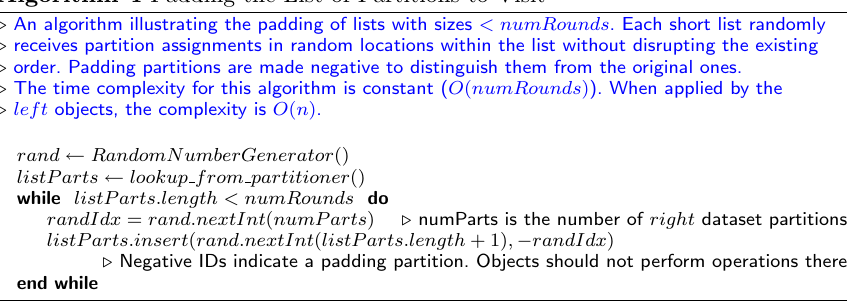
Algorithm 4 Padding the List of Partitions to